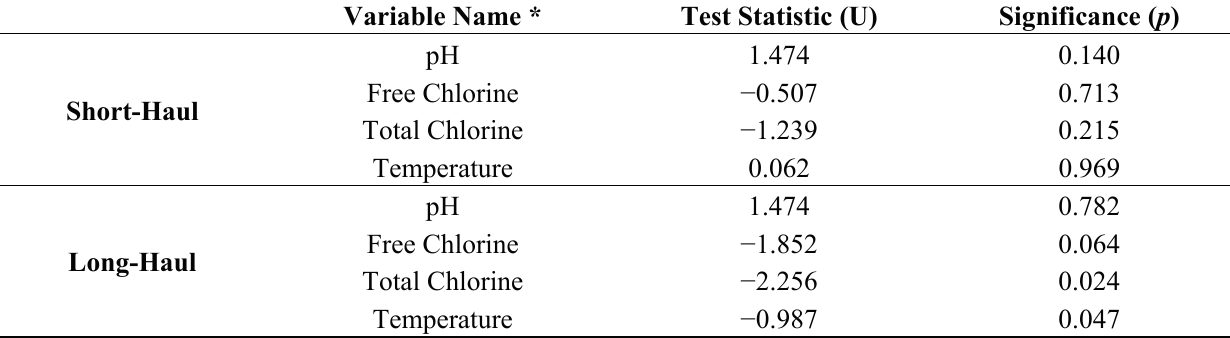
Table 7. Mann Whitney U test for differences of means across physical and chemical analysis results for long- and short-haul aircraft, using Galley (Fwd or Aft) as the independent